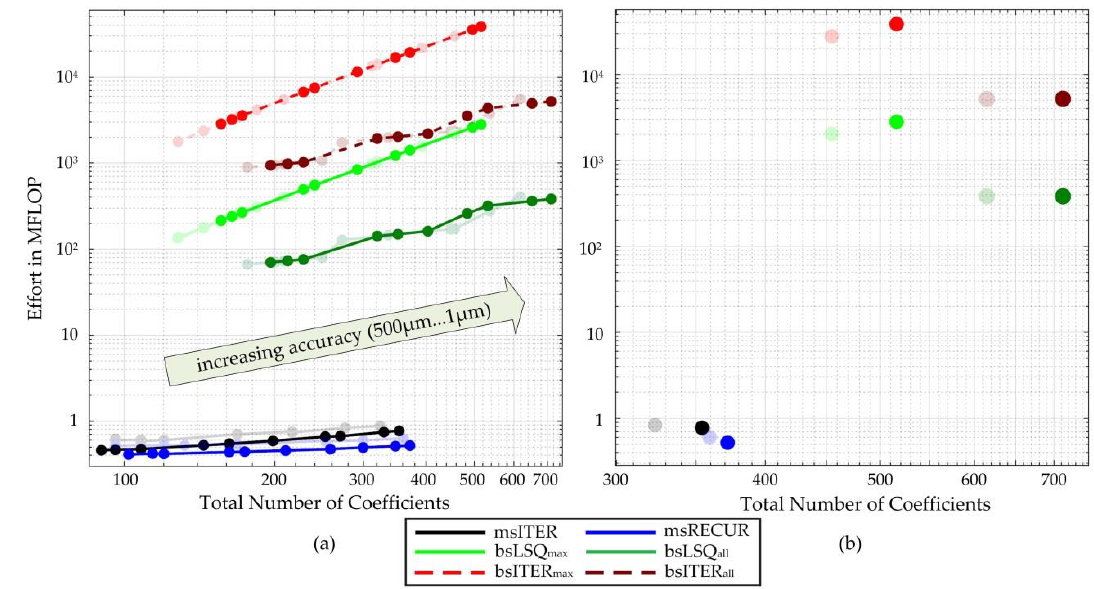
Figure 16. Comparison of the performance of the algorithms with decoupled drive coordinates. The values of the coupled calculation are shown transparent, cf. Figure 7. ( a ) Trend of the performance as a function of the accuracy. ( b ) Performance for the relevant accuracy of 1 µm.